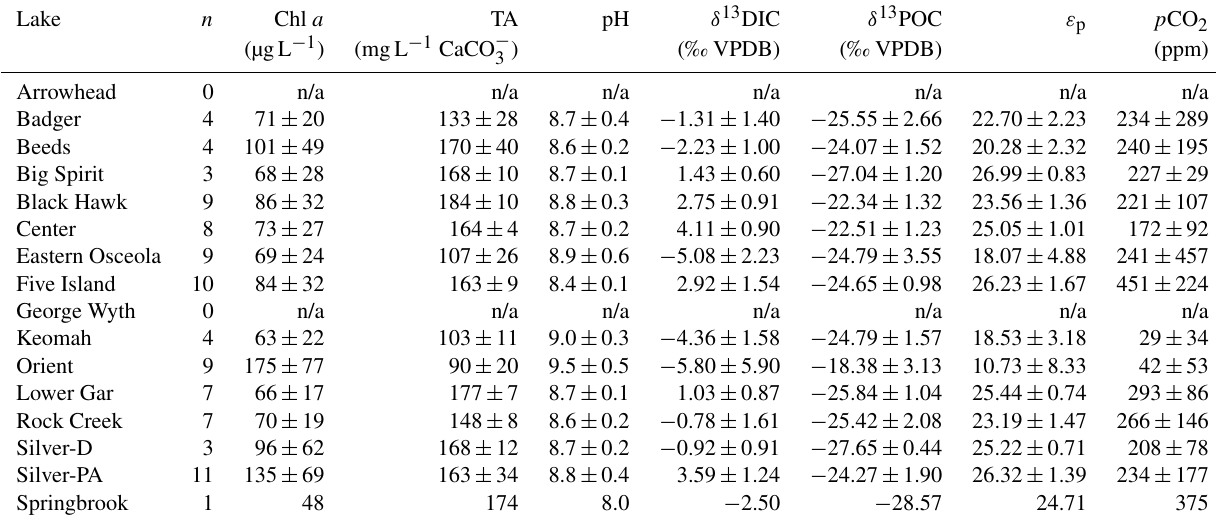
Table 2. Average chemical conditions during bloom events (Chl a >40µgL − 1 ) . Values are average ± SD of n observations occurring when Chl a exceeded 40µgL − 1 . Values are not reported for Arrowhead and George Wyth because Chl a values never exceeded this